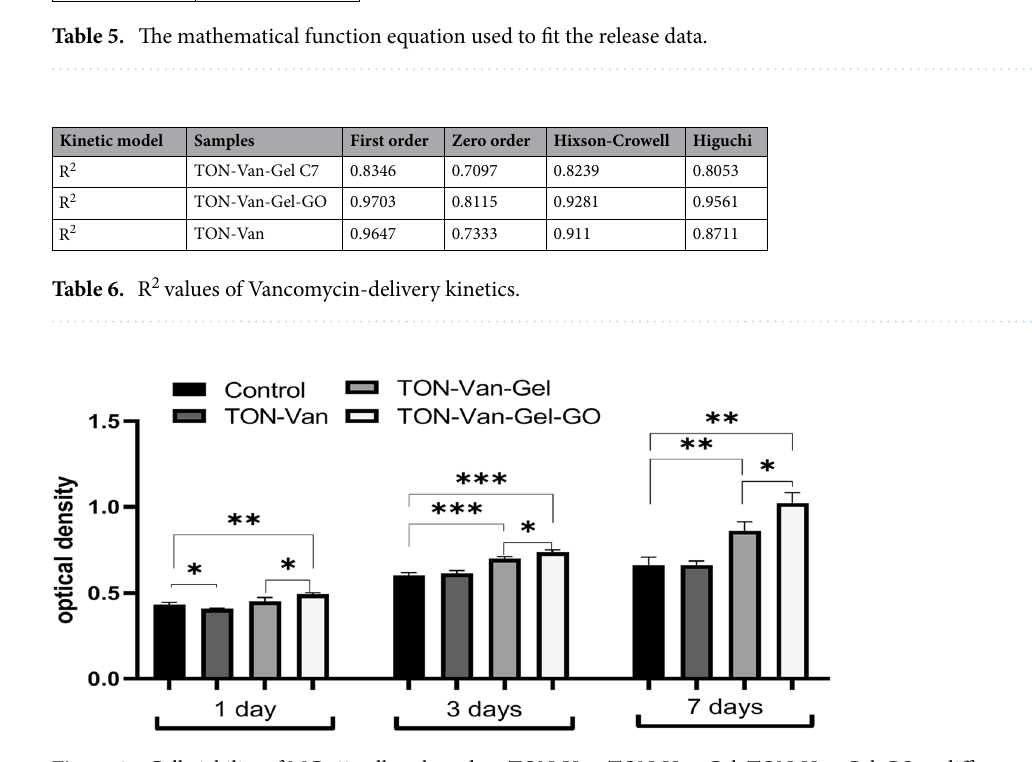
Figure 8. Cell viability of MG-63 cells cultured on TON-Van, TON-Van-Gel, TON-Van-Gel-GO at different time point using MTT assay. (* p < 0.05, ** p < 0.01, *** p < 0.001, n =